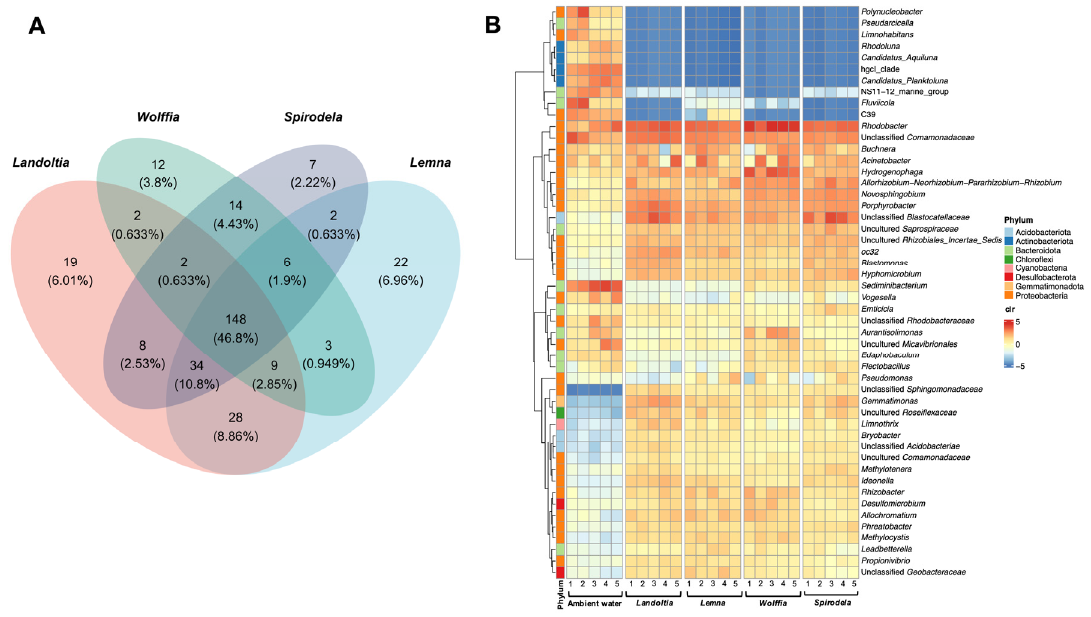
Figure 4. Candidate core microbiomes defined by bacterial genera that presented in every biological replicate of duckweed subtypes and ambient water, disregarding their relative abundance using ( A ) Venn diagram, and ( B ) heatmap representing the top 50 abundant core genera.